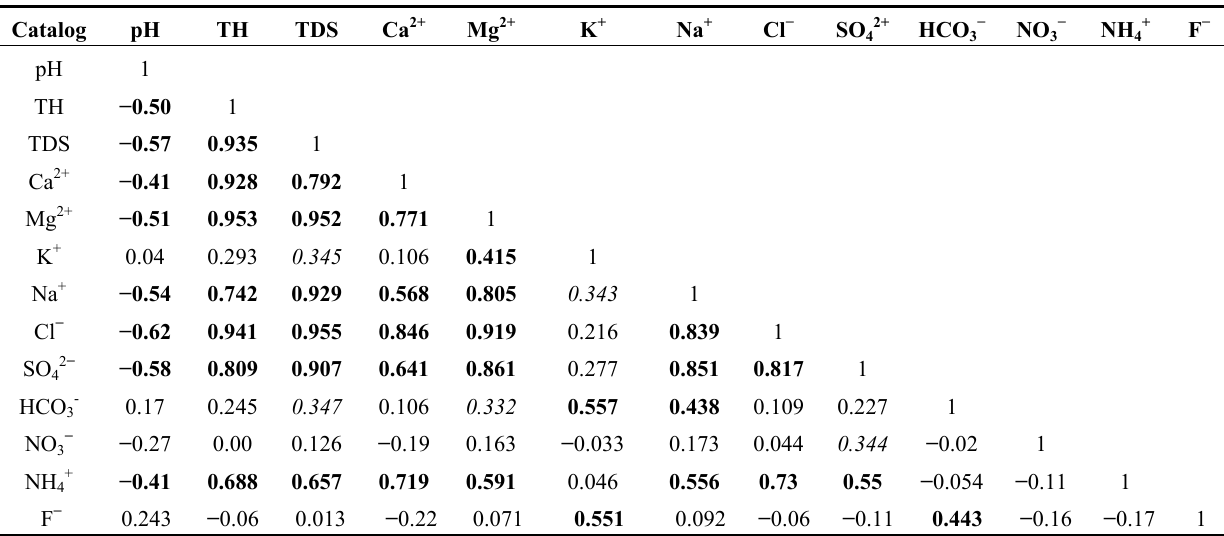
Table 2. Correlation matrix of the 13 physico-chemical water parameters. The values are the correlations coefficients ( r